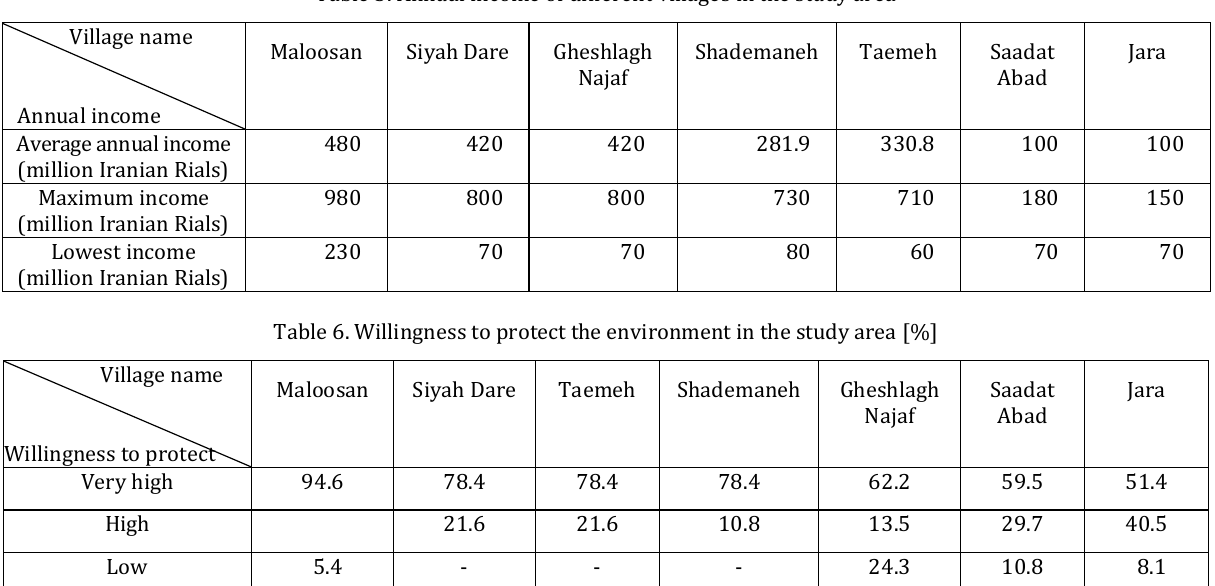
Table 5. Annual income of different villages in the study area